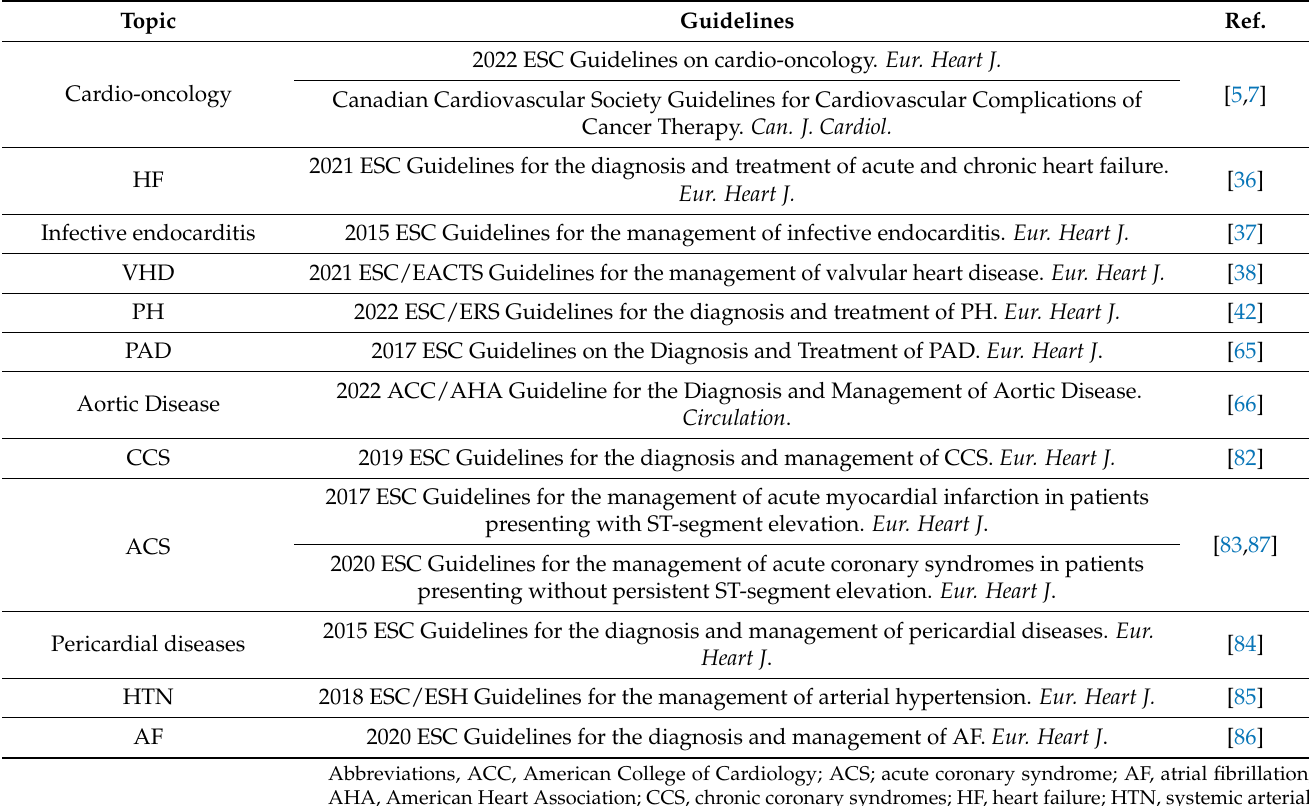
Table 4. Employed guidelines on cardio-oncology and on specific